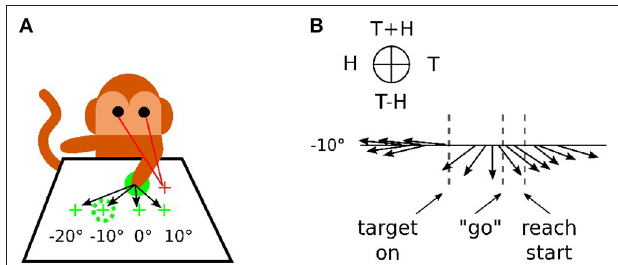
FIGURE 1 | Recording responses of the PPC neuronal population in macaques. (A) Experimental setup for a reaching task. The eye fixation (red crosses), the initial position of the hand (plain green circle) and the targets (dashed green circles) were located at − 20 ◦ , − 10 ◦ , 0 ◦ or + 10 ◦ horizontally. (B) response of the neuronal population for the target at − 10 ◦ only, revealing the evolution of the mixed reference frames encoded during the task. The figures are adapted and reproduced from Bremner and Andersen (2014) from Figures 1,